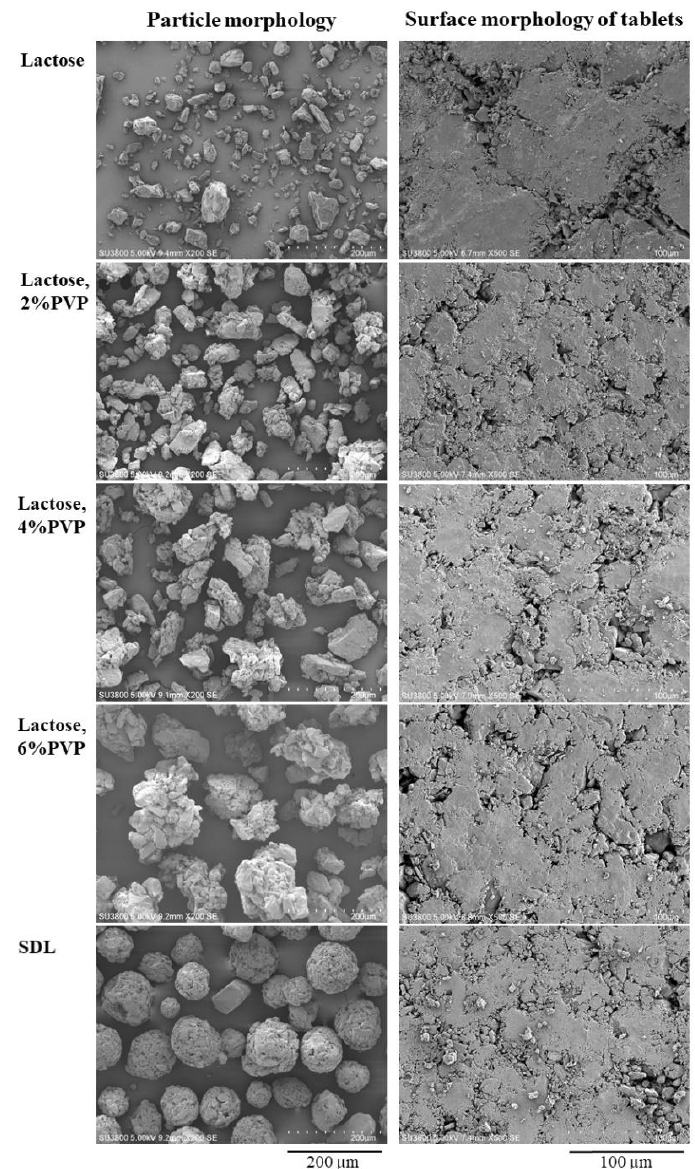
Figure 1. Particle morphology of lactose, SDL, and lactose agglomerates and surface morphology of tablets prepared using various diluents.